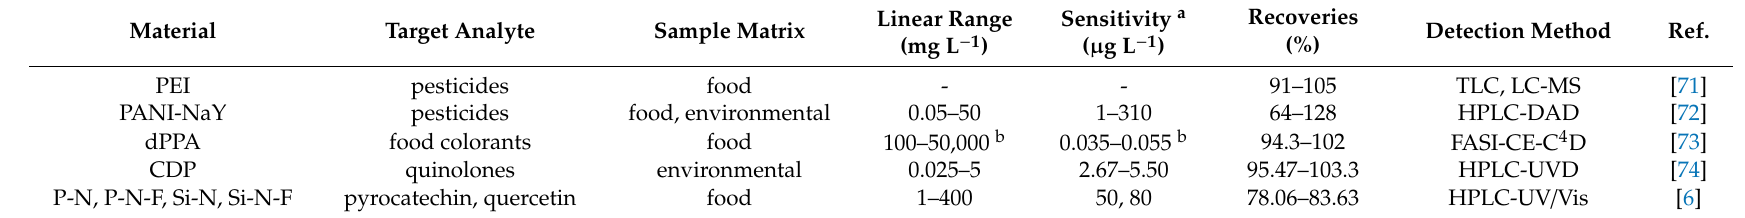
Table 7. Polymer-based